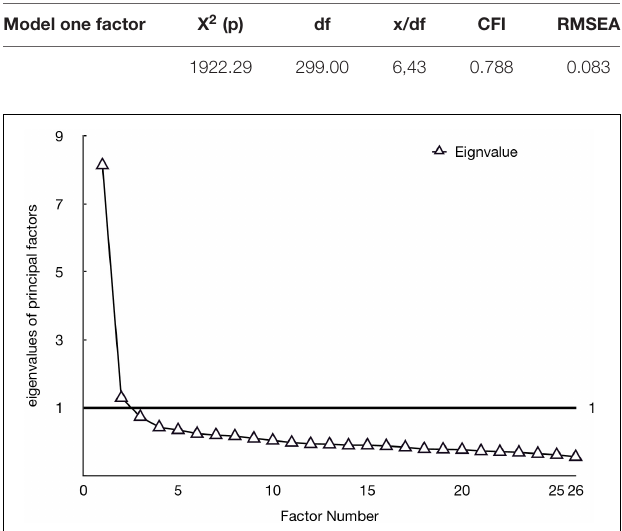
FIGURE 2 | Distribution of eigenvalues relative to factors.